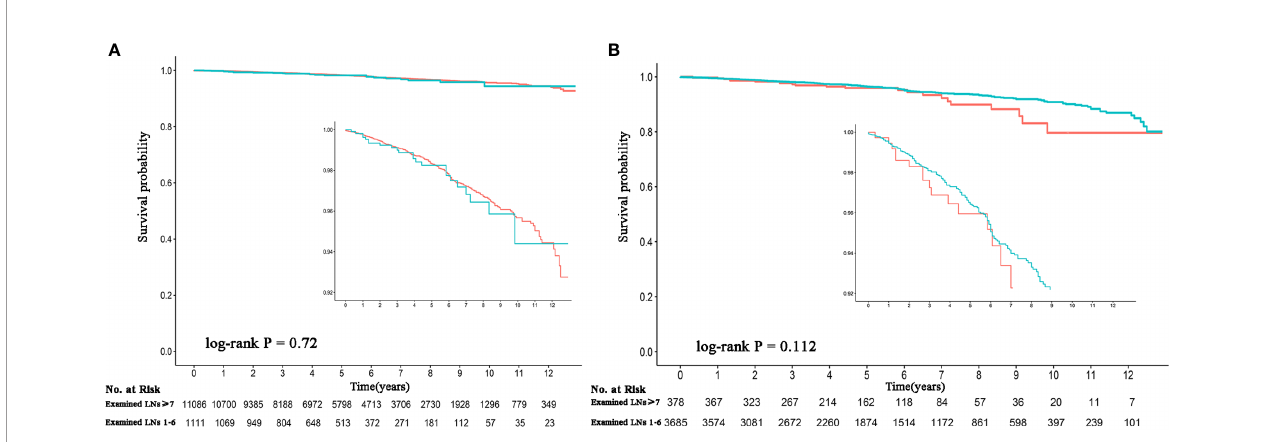
FIGURE 3 | Comparison of the survival probability between an adequate and inadequate number of LNs examined among observed node-negative patients. (A) All patients. (B) Patients aged ≥ 55 years. The red line represents >7 LNs examined, and the green line represents 1 – 6 LNs examined. LNs, lymph